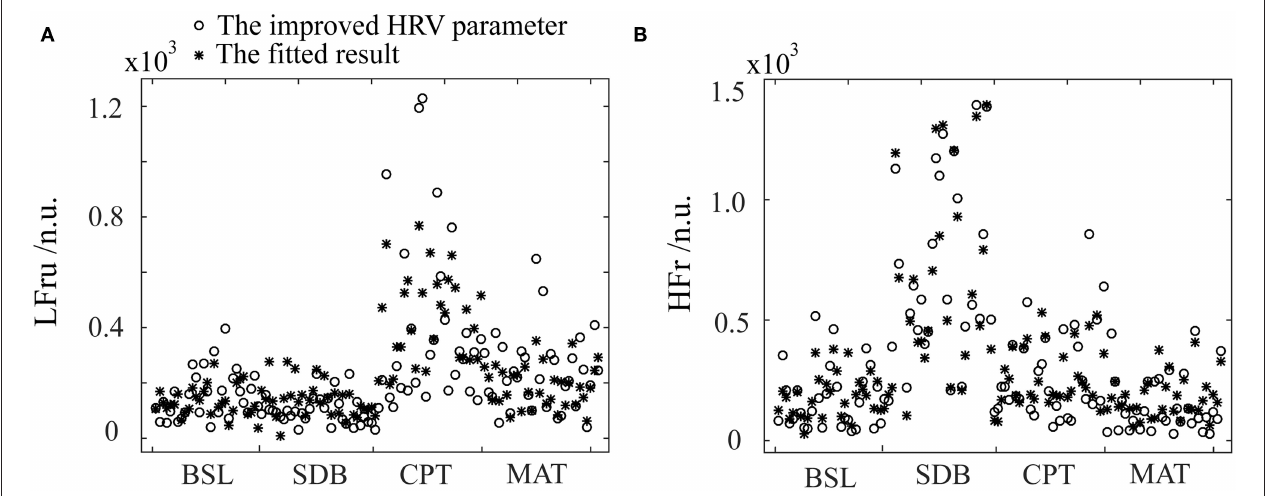
FIGURE 5 | The fitting results of the improved HRV parameters using the PPG features and stepwise regression. (A) LFru, low-frequency power of the improved HRV. (B) HFr, high-frequency power of the improved HRV. BSL, baseline state; SDB, slow deep breathing; CPT, cold pressor test; MAT, mental arithmetic test. The physiological mechanism of the improved HRV parameters are considered as: LFru mainly contains information on sympathetic activity, HFr reflects parasympathetic activity.